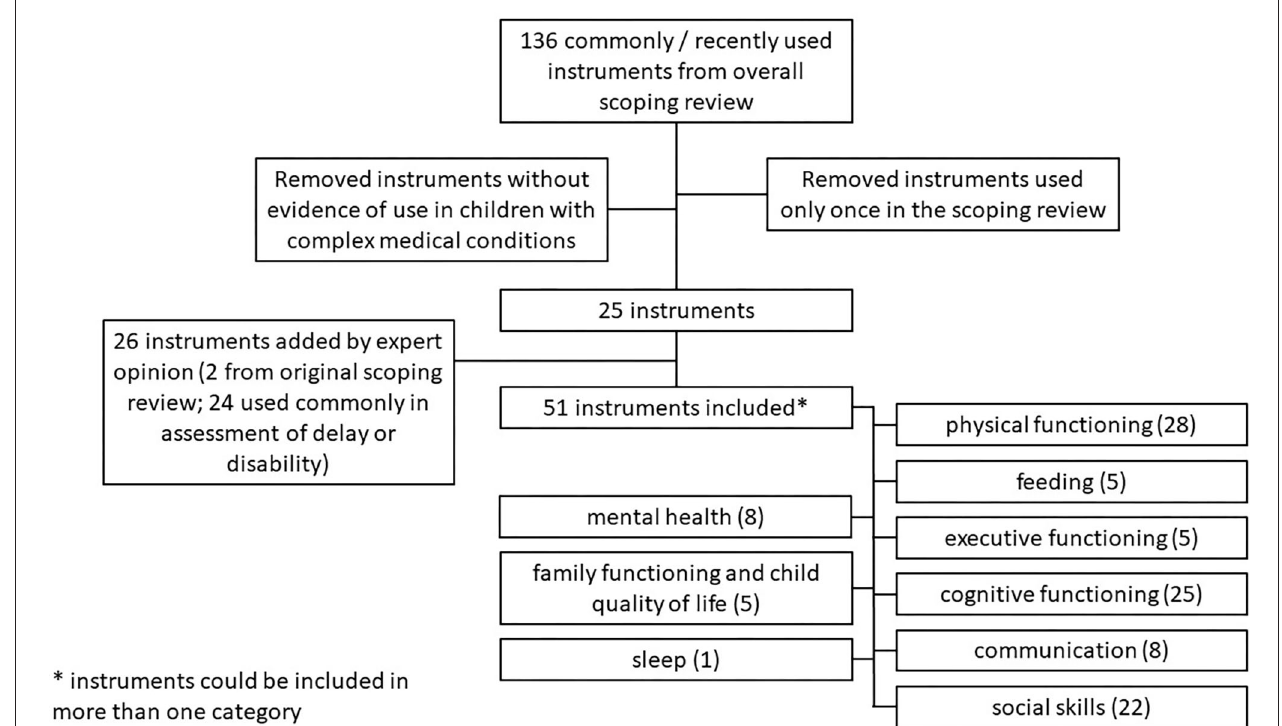
FIGURE 1 | Flow diagram of included instruments by